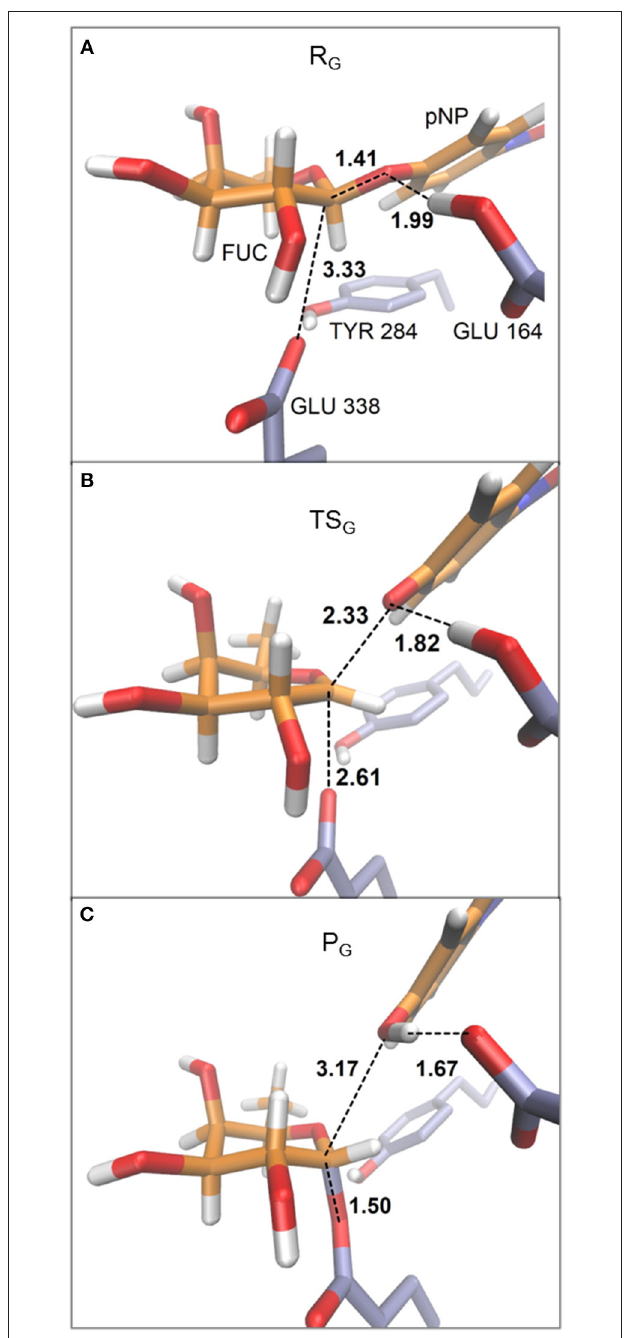
FIGURE 5 | Representative structures for reactant (A) , transition state (B) , and product (C) for the glycosylation reaction. The depicted geometries correspond to frame G I within the QM(large)/MM partition and with the QM region described at the PBE0/TZVP level. Distances are in